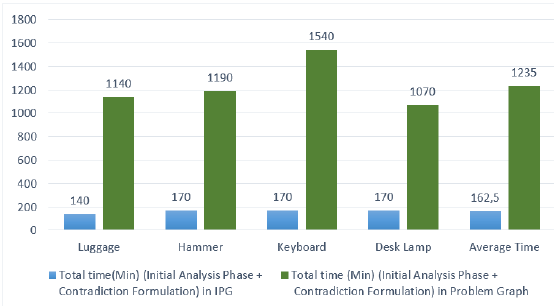
Figure 14. Time-based Comparison of the IPG method and Problem